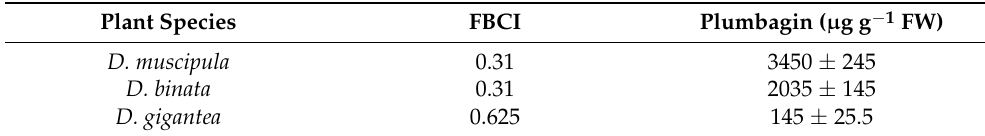
Table 2. Comparison of plumbagin content in tetrahydrofuran extracts from Dionaea muscipula , Drosera binata and Drosera gigantea and their synergistic potential with silver nanoparticles towards Pseudomonas aeruginosa ATCC